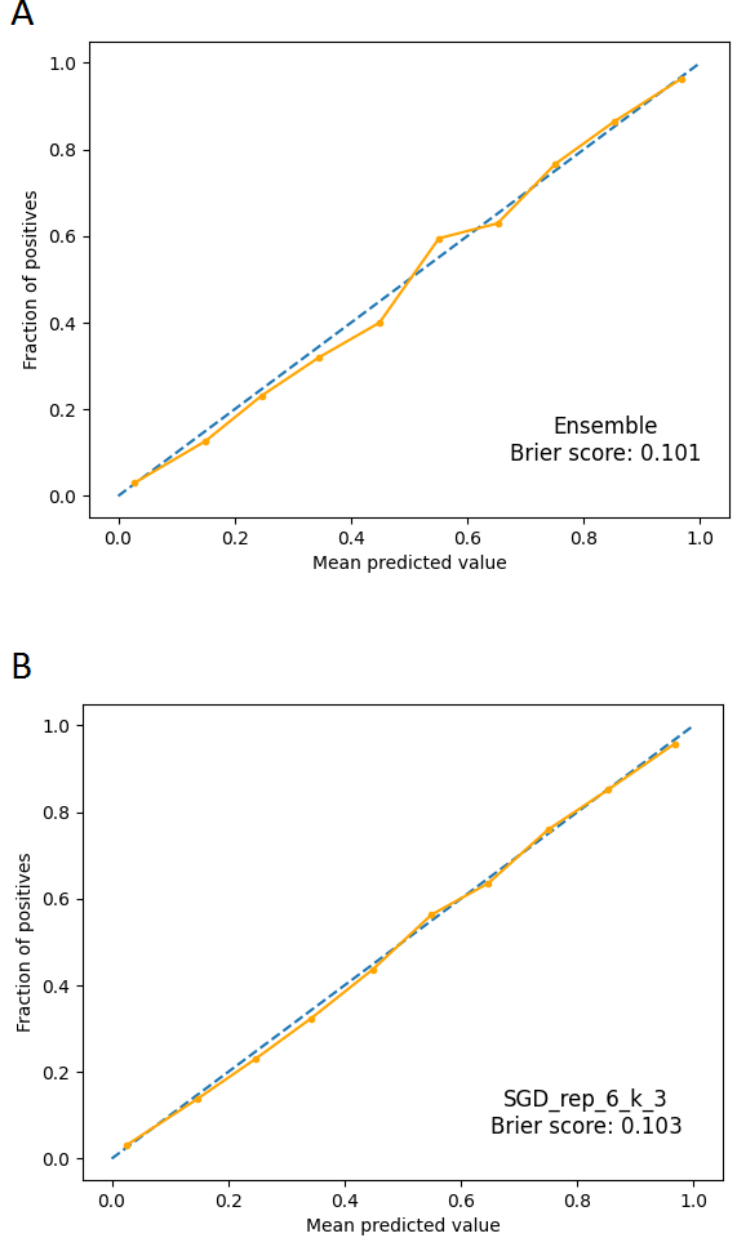
Figure 4. Calibration plots. The dashed line represents a perfectly calibrated ideal model; the continuous line represents the applied model. Panel ( A ): calibration plot for ensemble model. Panel ( B ): calibration plot for SGD model.